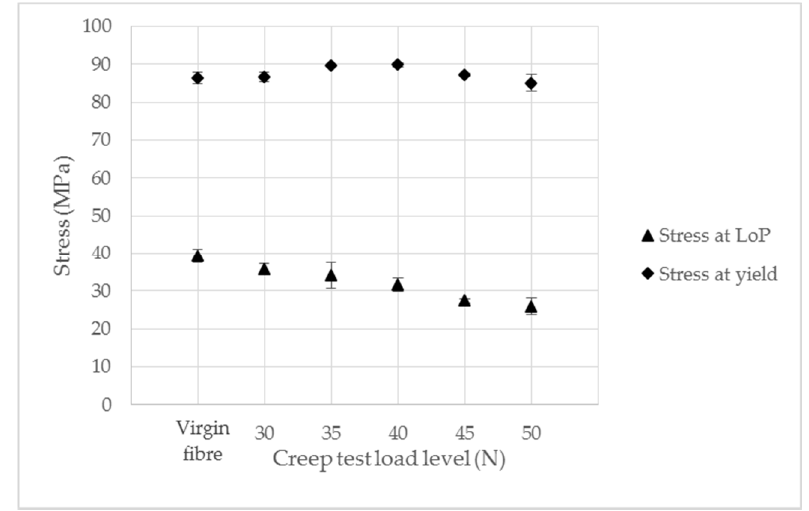
Figure 12. Average stress at proportional limit (LoP) and yield for fibres following creep tests exposing fibres to a fixed load for 1 hour. Each point is the average of three results, and error bars represent sample standard deviation. Virgin fibre data are included for comparison.